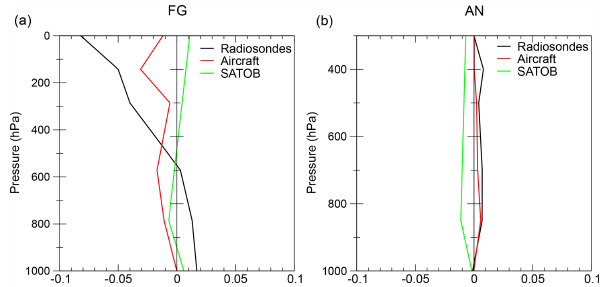
Figure 11. First-guess (a) and analysis (b) RMS differences (REANA–NOWPROF experiments) computed against radiosondes (black), aircraft (red) and satellite observations (SATOB, green) ob- servations for the zonal wind component (ms − 1 ); negative values correspond to a positive impact of the wind